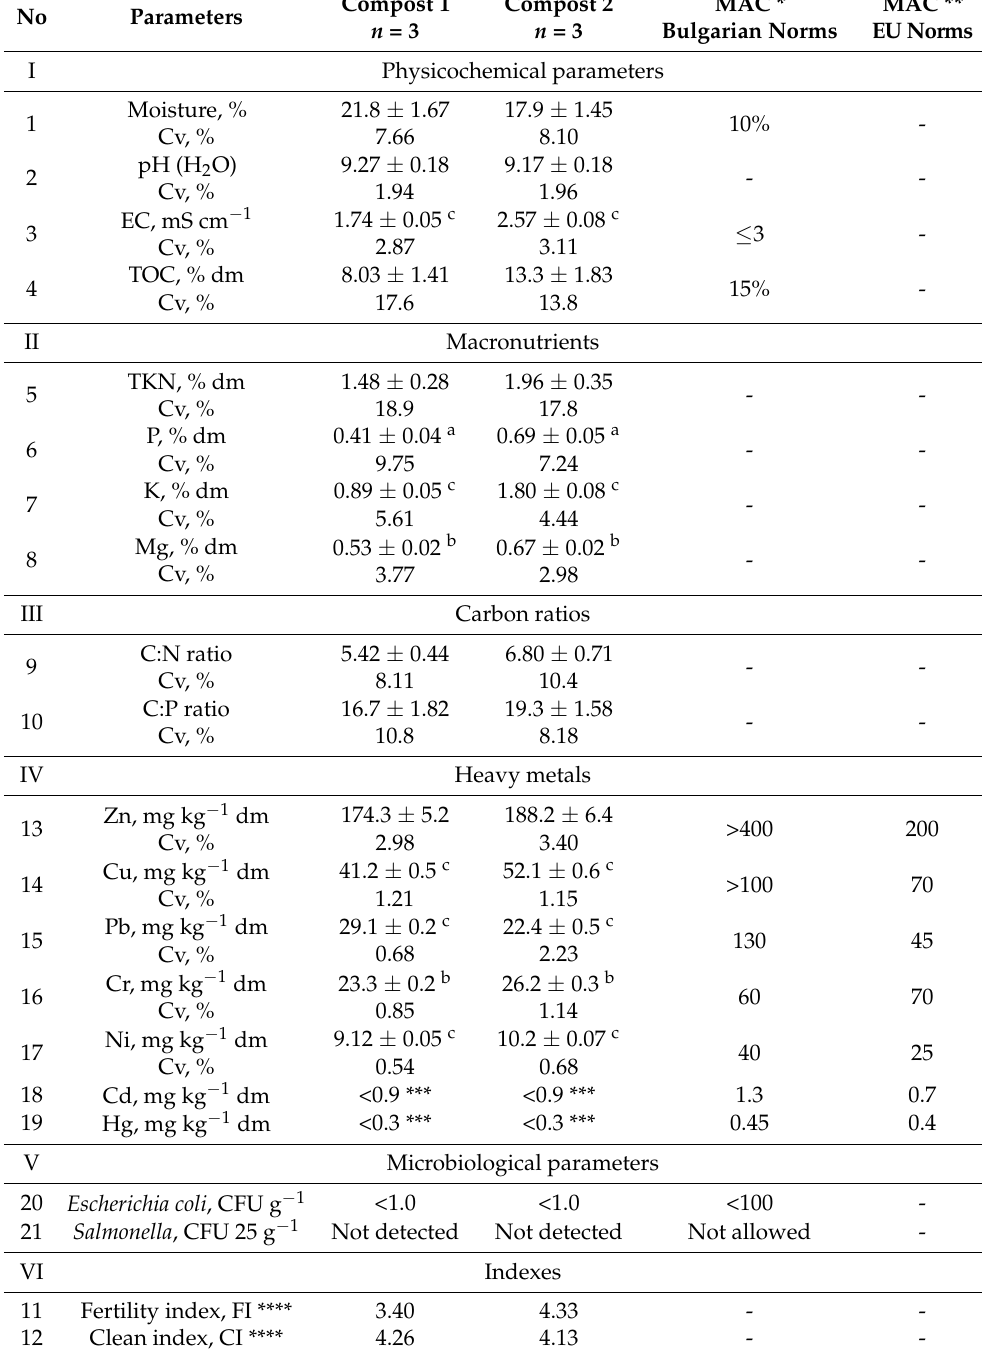
Table 3. Mean ± SD values of the monitored parameters of the tested